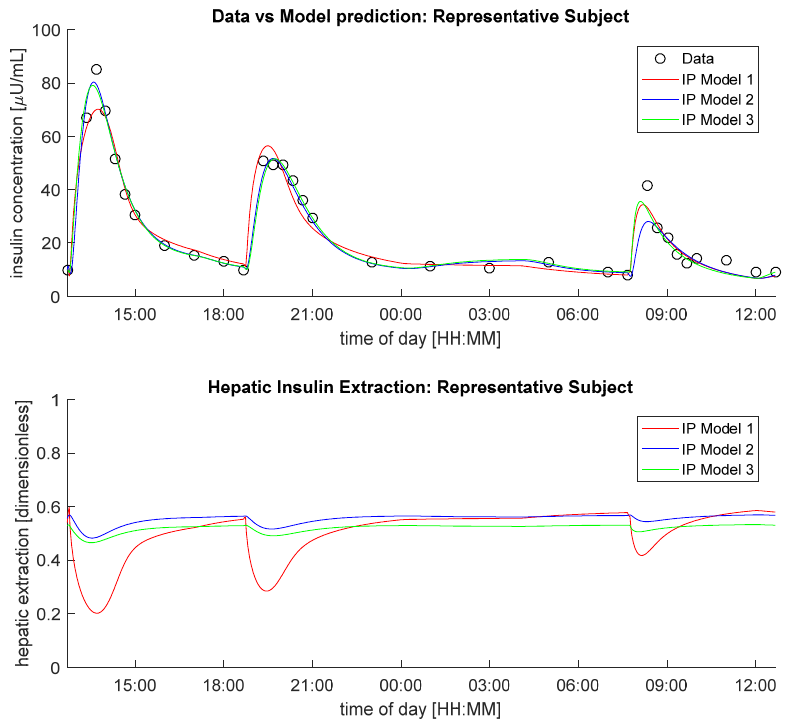
Figure 1. Insulin concentration data in a representative subject (black circles) vs. model predictions (continuous lines, top panel) and predicted hepatic insulin extraction (bottom panel) provided by IP Model 1(red line), IP Model 2 (blue line) and IP Model 3 (green line), coupled with Model C.